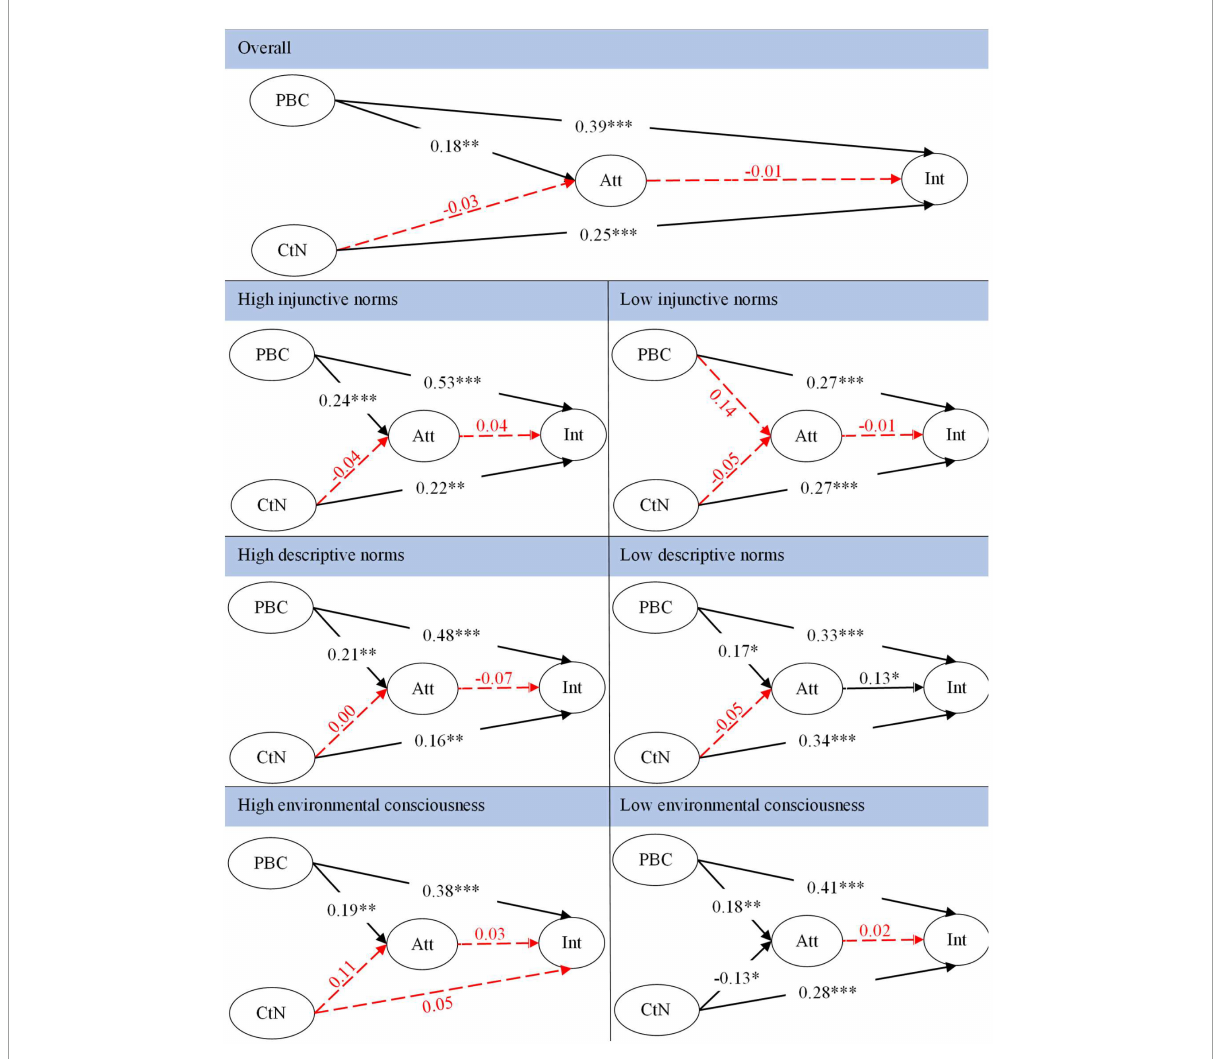
FIGURE2 The measurement model overall and for high/low injunctive norms, descriptive norms, and environmental consciousness. ∗ p < 0.05, ∗∗ p < 0.01, and ∗∗∗ p <